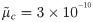
Impact of effective polyploidy on the probability of evolutionary rescue.(A, C) The probability that at least one mutation from the SGV survives in the new environment (PSGV; linear scale) and (B, D) the probability that at least one mutation arises in the new environment and survives (PDN; log scale), plotted as a function of ploidy, for a recessive mutation (A, B) or a dominant mutation (C, D). The different colored curves indicate probability of division before death of phenotypically wild-type (sensitive) cells in the new environment, pS, varying from 0 (black) to 0.45 (magenta) in increments of 0.05. The remaining parameters are fixed: probability of division before death of phenotypically mutant (resistant) cells, pR = 0.9; mutational cost in the old environment, s = 0.1; population size at the time the environment changes, N = 2 × 108; and per-copy mutation rate, μ˜c=3×10−10. This figure can be reproduced using code deposited on Dryad (http://dx.doi.org/10.5061/dryad.8723t). SGV, standing genetic variation.